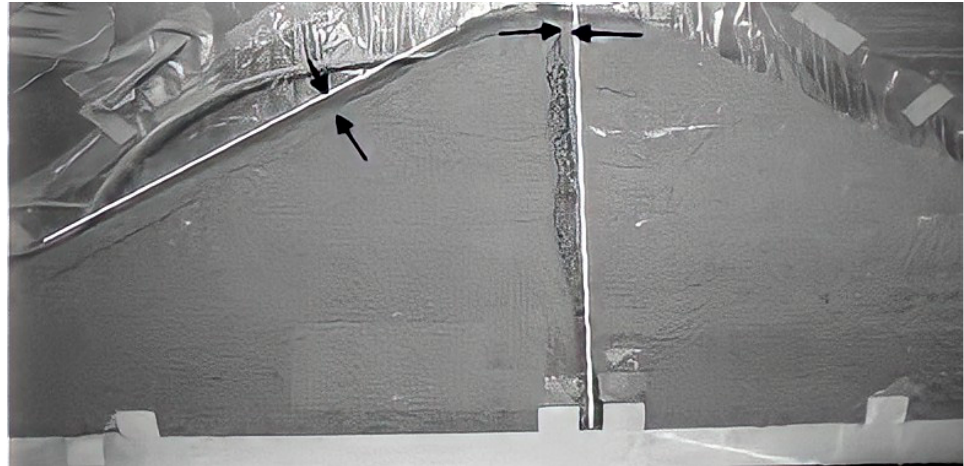
Figure 14. Meijaran dam model after centrifuge testing.